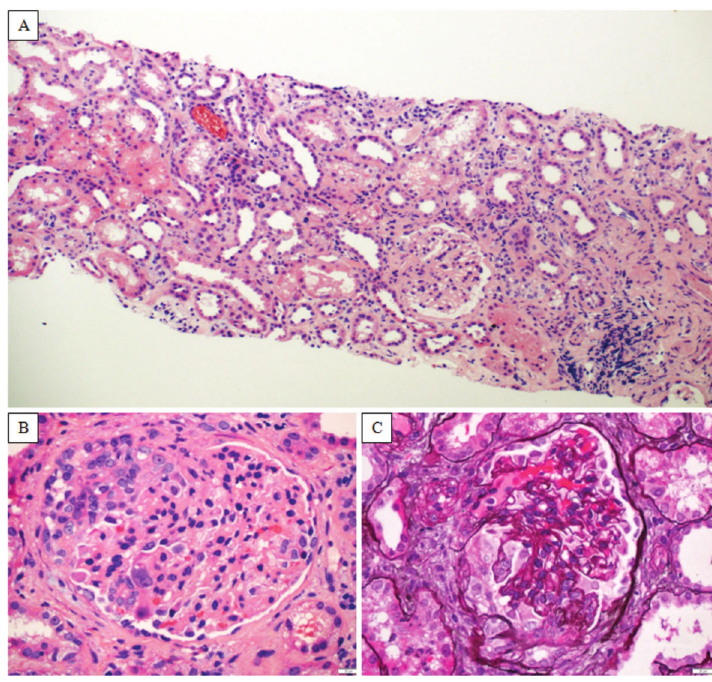
Figure 2. Kidney biopsy: A , Chronic tubulointer- stitial in fl ammatory in fi ltrate composed mainly by lymphomononuclear cells (H&E, 100 (cid:1) magni fi - cation). B , The glomerulus exhibits a cellular crescent and mesangial hypercellularity (H&E, 400 (cid:1) magni fi cation). C , Multifocal rupture of the glomerular basement membrane, with a cellular crescent in the Bowman ’ s space (methenamine silver, 400 (cid:1) magni fi